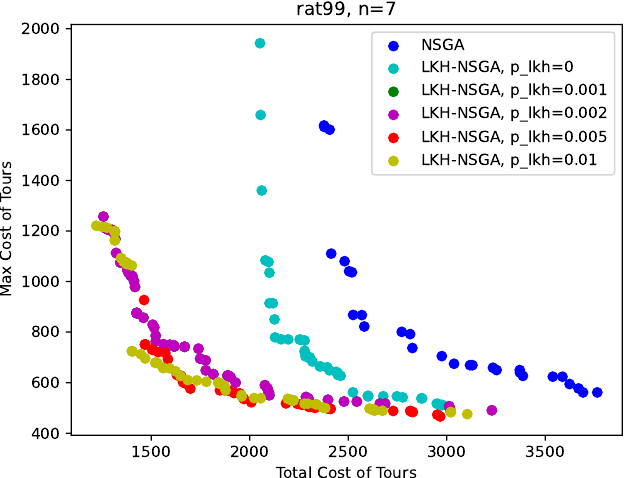
Figure 5. The Pareto fronts of LKH-guided NSGA with different guidance rate p LKH